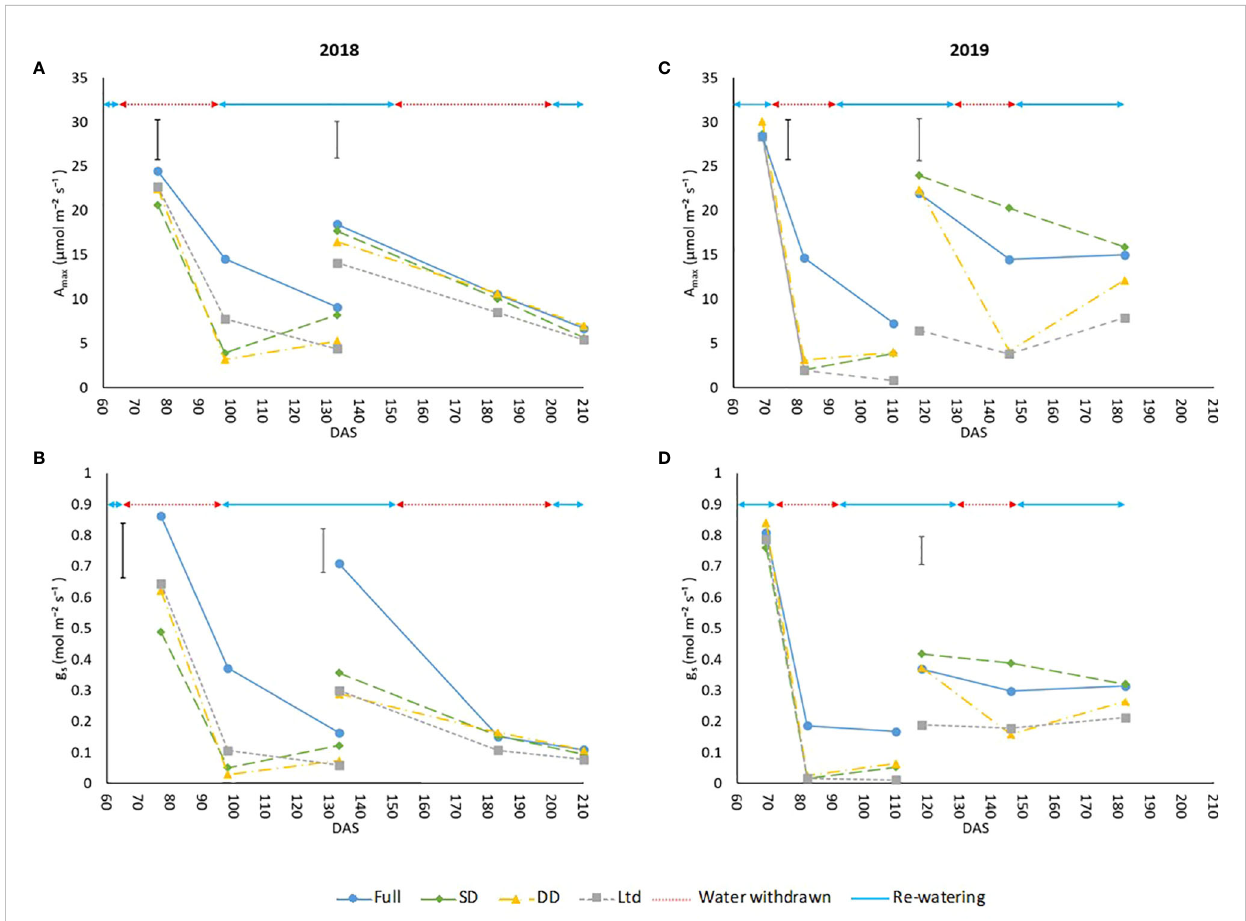
FIGURE 2 The maximum assimilation rate (A max ) and stomatal conductance (g s ) of sugar beet grown under four irrigation regimes, measured using an infra-red gas analyser (Li6800, LiCor, Nebraska, US). Measurements were taken from 2 leaves Measurement leaf 1 covers the fi rst drought and measurement leaf 2 the second drought in 2018 and 2019. (A) leaf 1 (LSD=4.54 DF=190 P<0.001), leaf 2 (LSD=4.16 DF=191 P=0.002). (B) leaf 1 (LSD=0.177 DF=190 P=0.005), leaf 2 (LSD=0.141 DF=191 P=0.002). (C) leaf 1 (LSD=4.45 DF=220 P<0.001), leaf 2 (LSD=4.75 DF=255 P<0.001). (D) leaf 1 (P=0.133), leaf 2